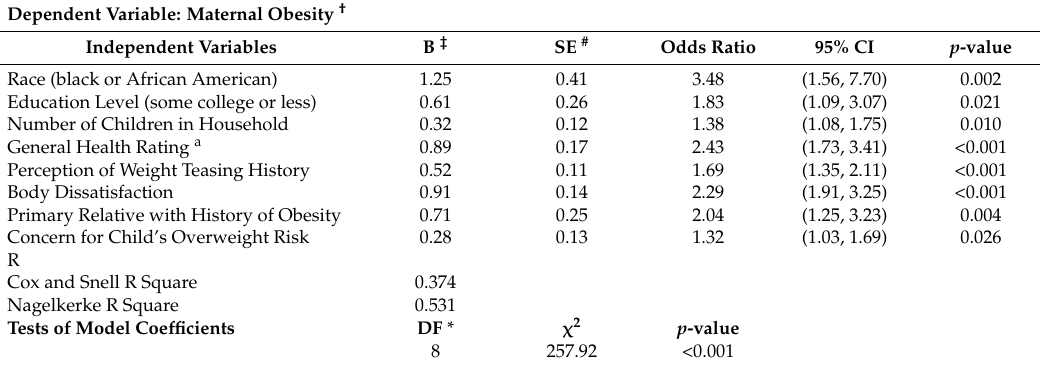
Table 3. Binomial Logistic Regression of Variables Associated with Maternal Obesity ( n =